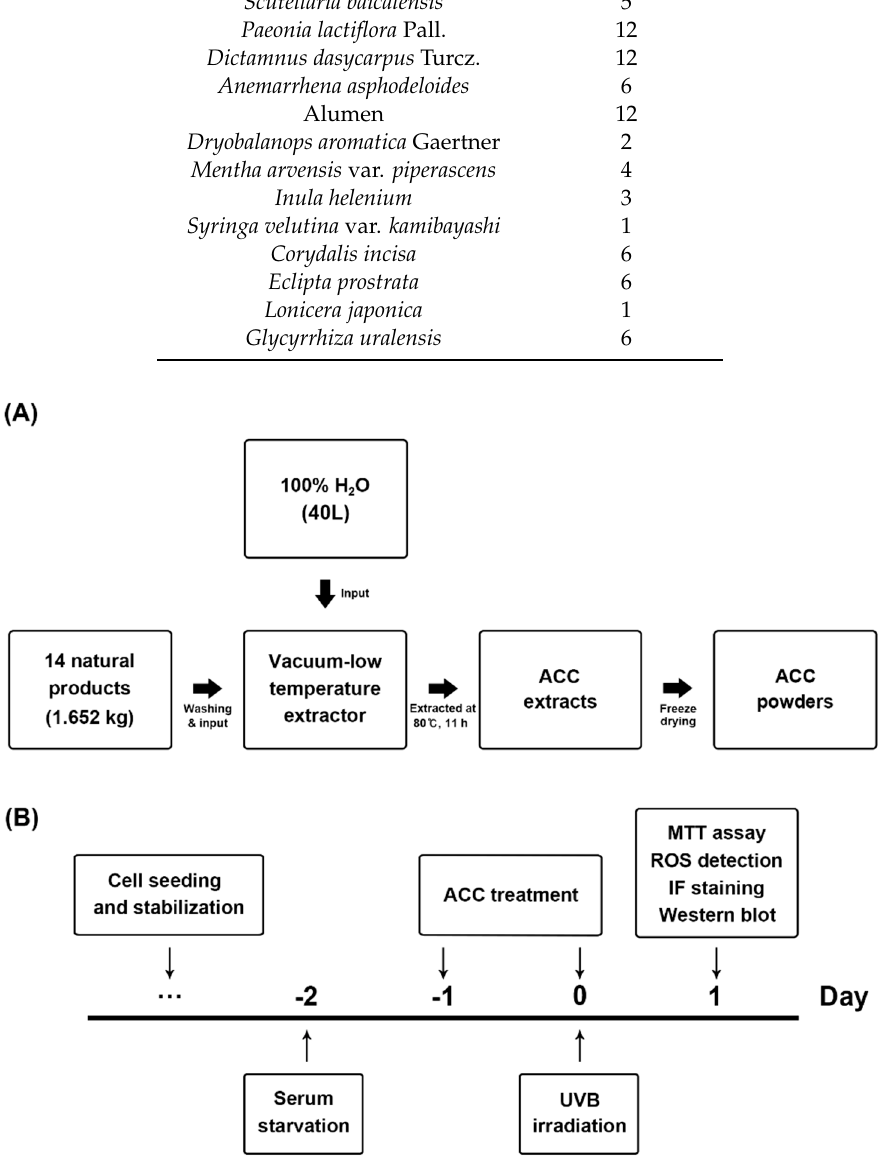
Figure 1. Process flow for extracting advanced cooling composition (ACC) and schematic diagram of the experimental design to determine whether ACC treatment affects heat shock-induced human keratinocytes (HaCaT) cells. ( A ) ACC extraction process. ACC is produced by the distilled extraction of 14 natural products, including phellodendron bark. ( B ) Timeline of ultraviolet B (UVB) irradiation and ACC treatment in HaCaT cells. HaCaT cells were treated with ACC starting 1 day before UVB irradiation and replaced daily until experiments were performed. After that, each HaCaT cell was evaluated by 3-(4,5-dimethyl-2-thiazolyl)-2,5-diphenyl-2H-tetrazolium bromide (MTT) assay, reactive oxygen species (ROS) detection, immunofluorescence staining, and Western blot analysis at 1 day after UVB irradiation.